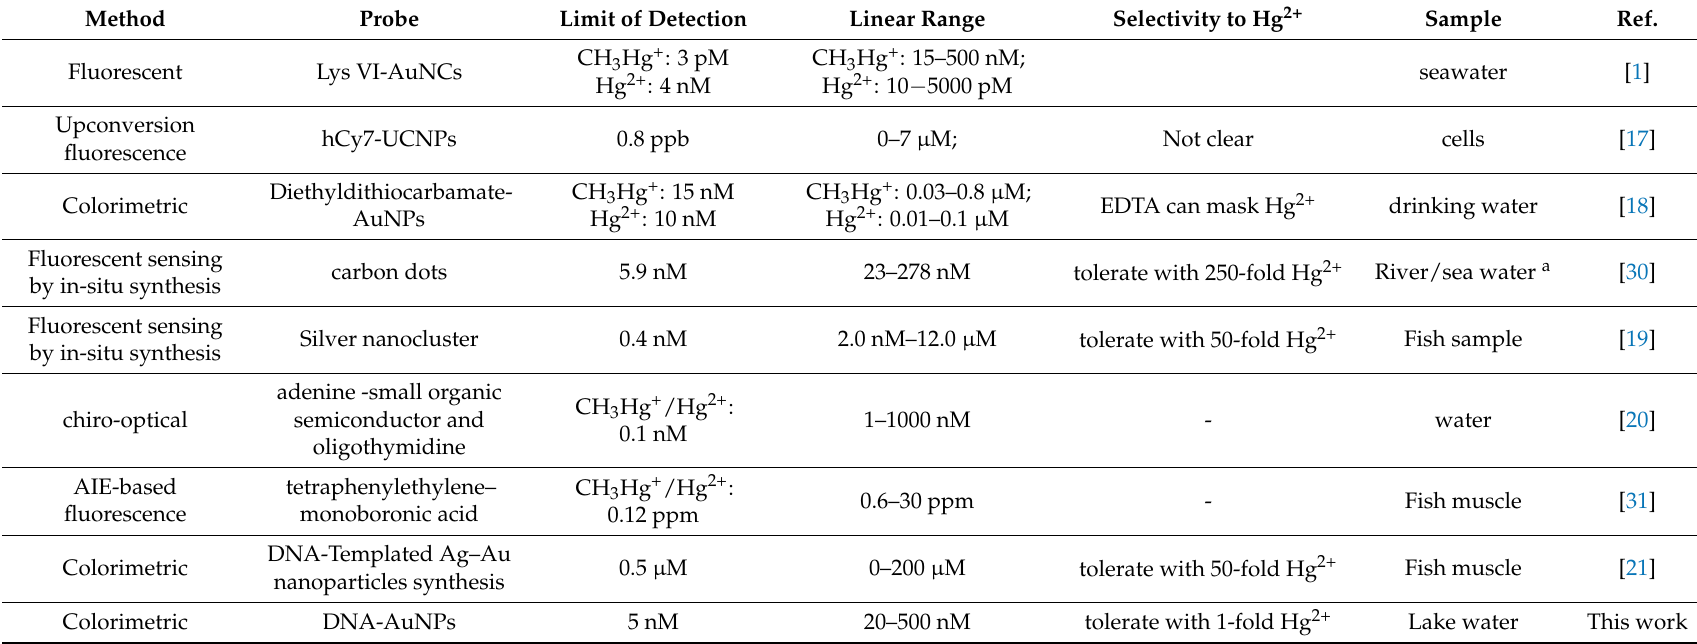
Table 2. Summarize of some typical method of CH 3 Hg +